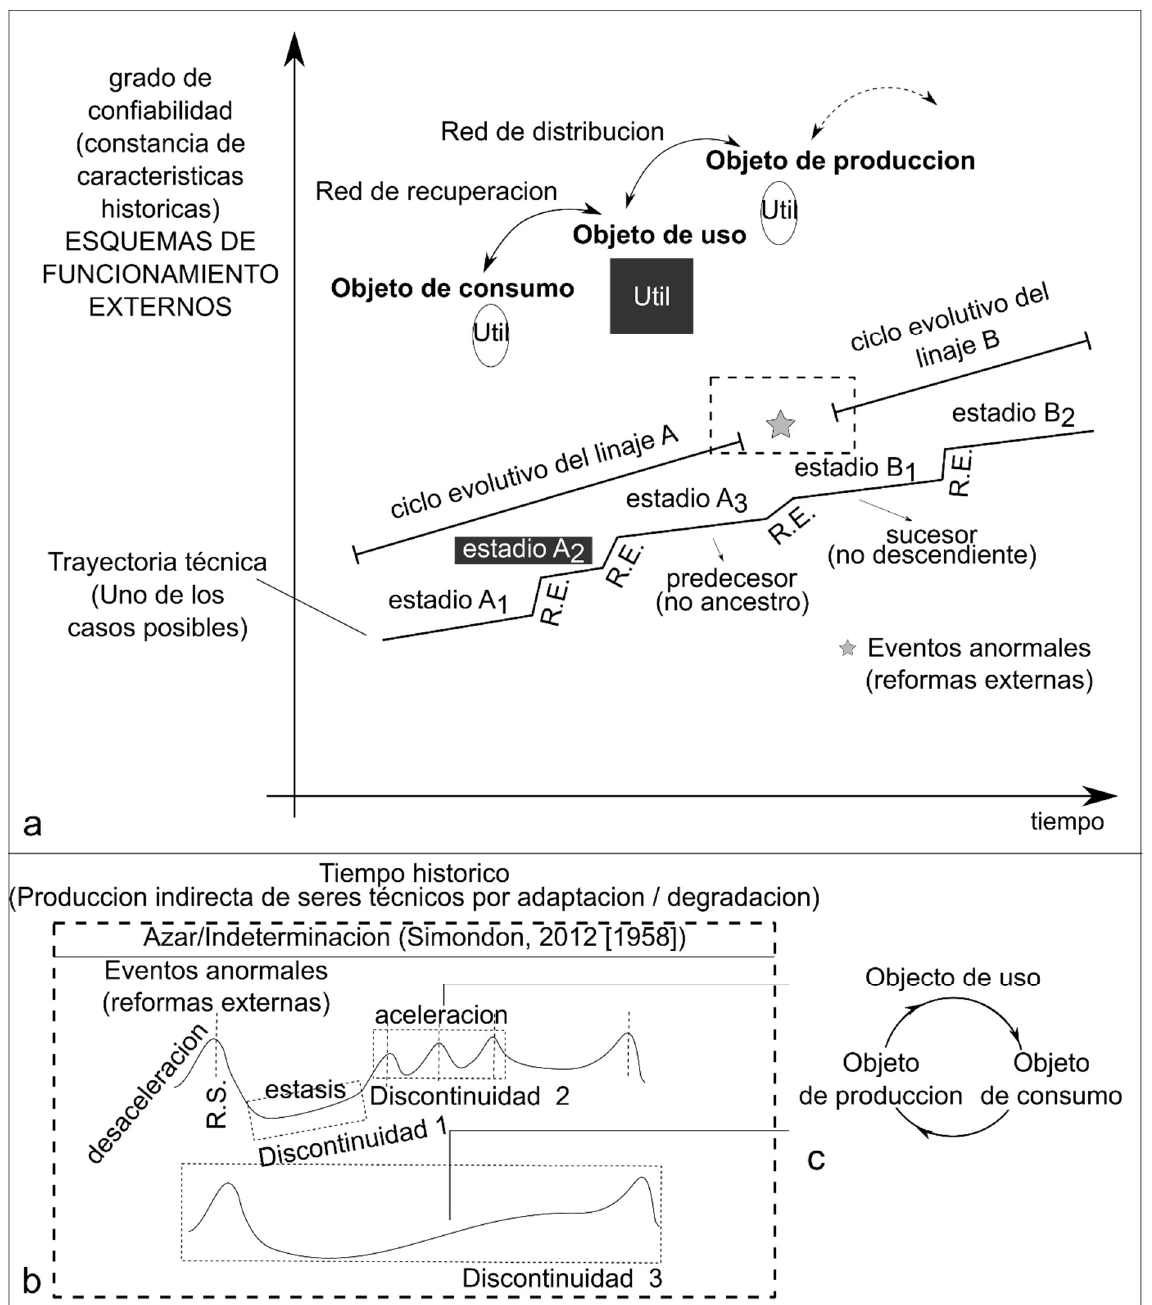
Figura 15. Estructura de las trayectorias técnicas prehistóricas: (a) definición general, (b) rol del azar en las transformaciones internas, (c) transformaciones psicosociales de